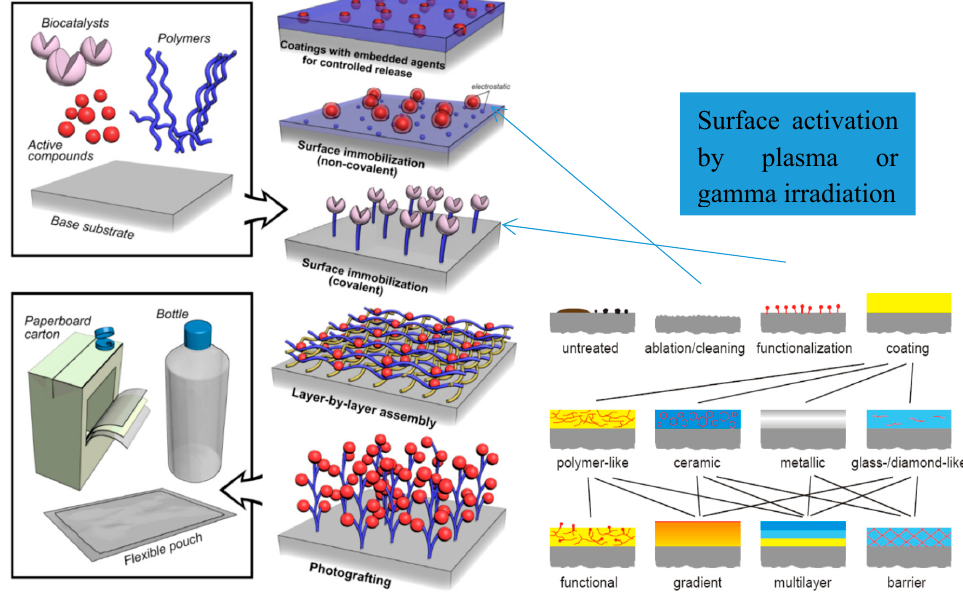
Figure 2. Summary of coating technologies (adapted from [135–140]).